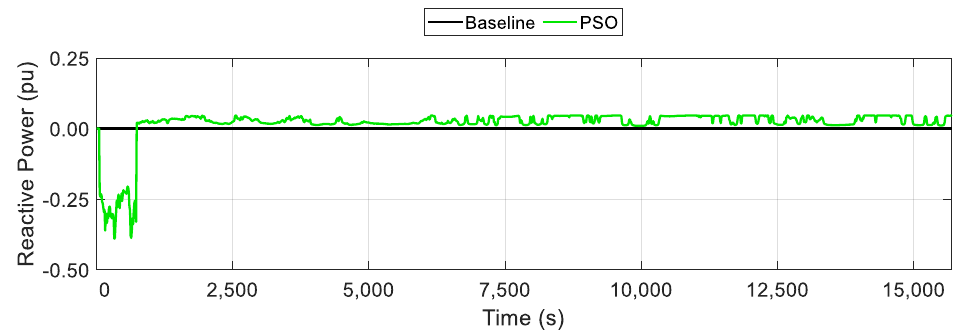
Figure 7. Reactive Power Comparison Between Baseline and PSO for the Hardware PV Inverter 1.